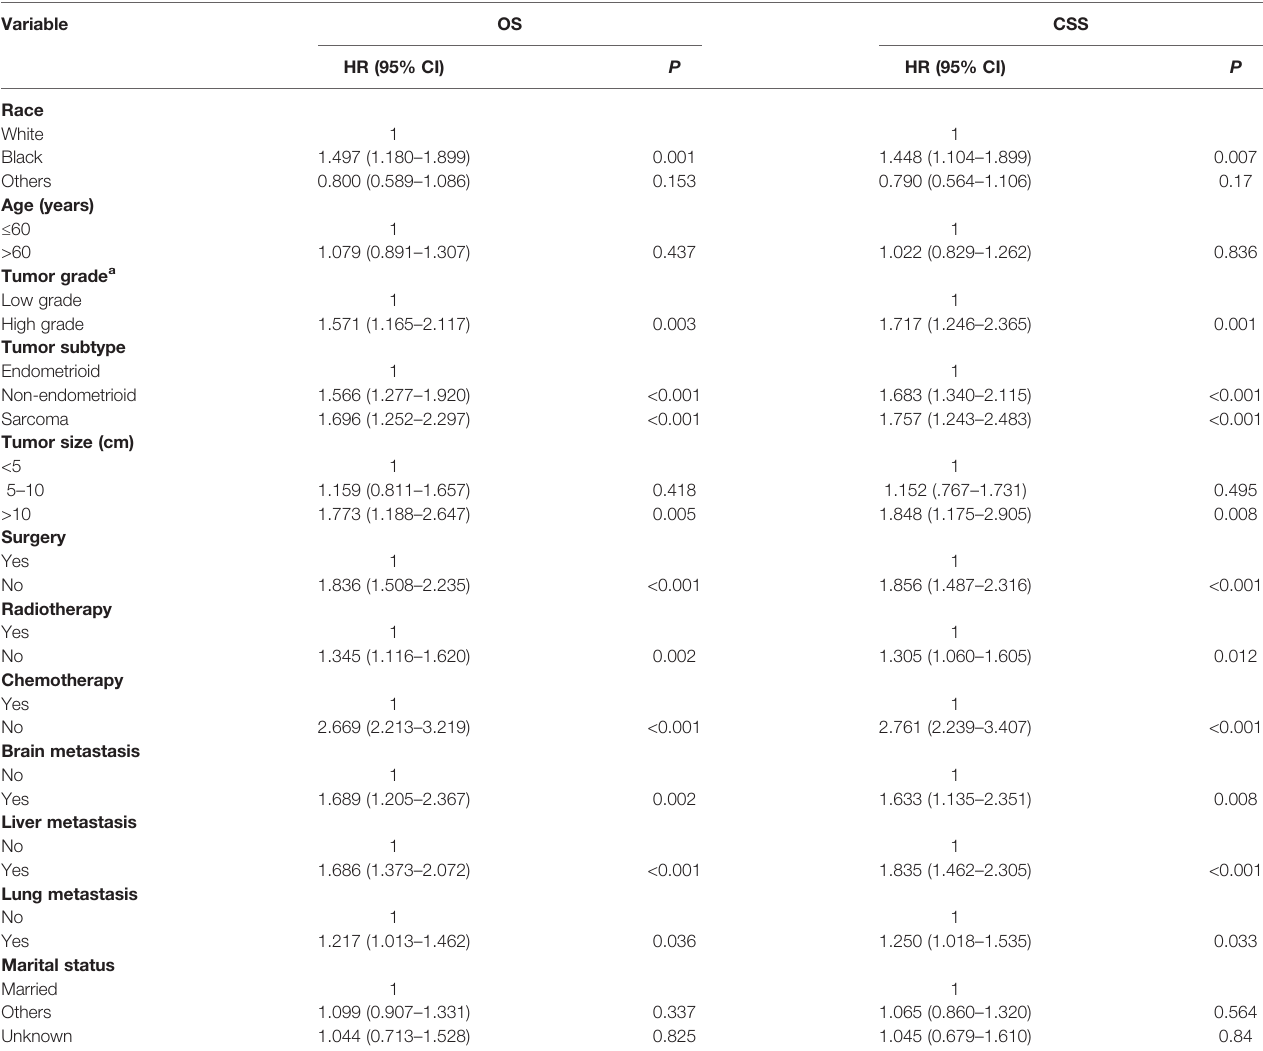
TABLE 2 | Univariate Cox analysis of variables in endometrial cancer bone